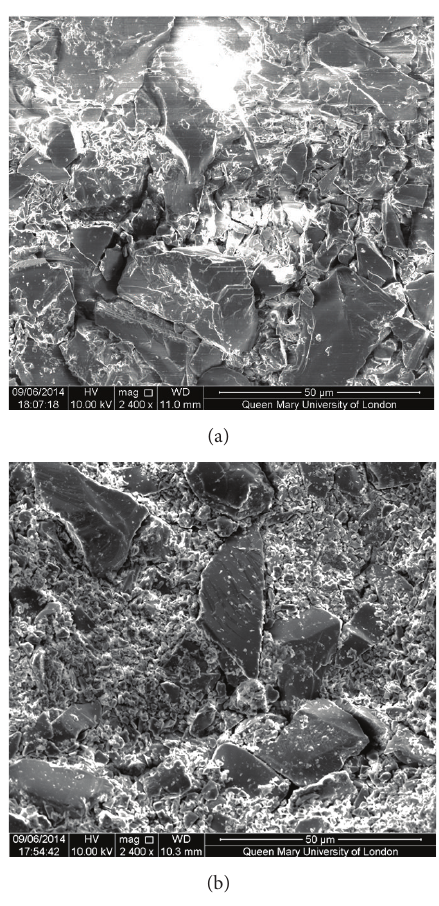
Figure 7: SEM image of the alumina (a) and Na0SR (b) remnant at the base of the cut cavities after air